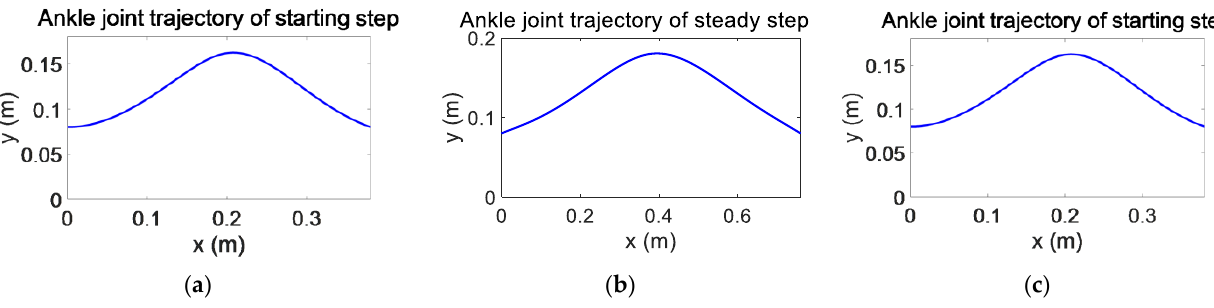
Figure 4. The motion trajectory of ankle joint in the starting ( a ), steady ( b ), and final ( c ) steps. Figure 3a – c shows the motion trajectory of the hip joint in the starting, steady, and final steps, respectively. Similarly, the movement of the ankle joint is shown in Figure 4a – c.